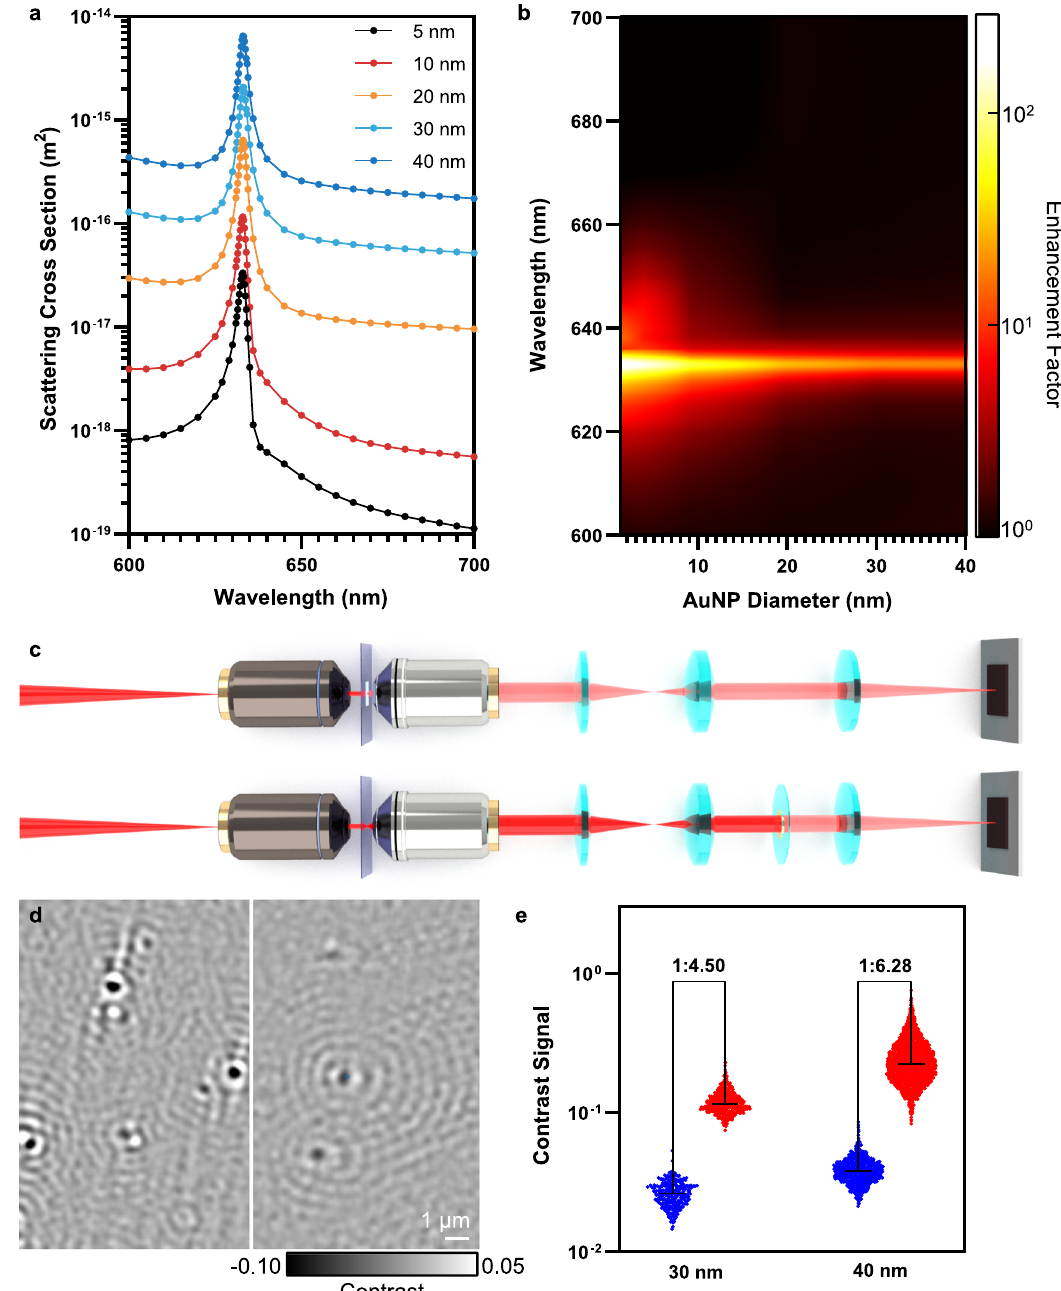
Fig. 4 Modeling and validation on guided resonance-enhanced scattering. a FEM simulated scattering cross-section spectrum for AuNPs on a resonant PC surface. b Contour map of the PC enhancement factor on the AuNP scattering cross section as a function of AuNP diameter and excitation wavelength. c Schematic illustration of the PRISM system (upper) and interferometric scattering microscopy (iSCAT) with a gold disk placed in the Fourier plane to attenuate the reference beam (lower). d Representative differential interferometric images of AuNPs ( d = 40 nm) obtained by PRISM (left) and iSCAT (right). e Comparison of signal contrast obtained respectively by PRISM (red) and iSCAT (blue). n > 400 for each size of